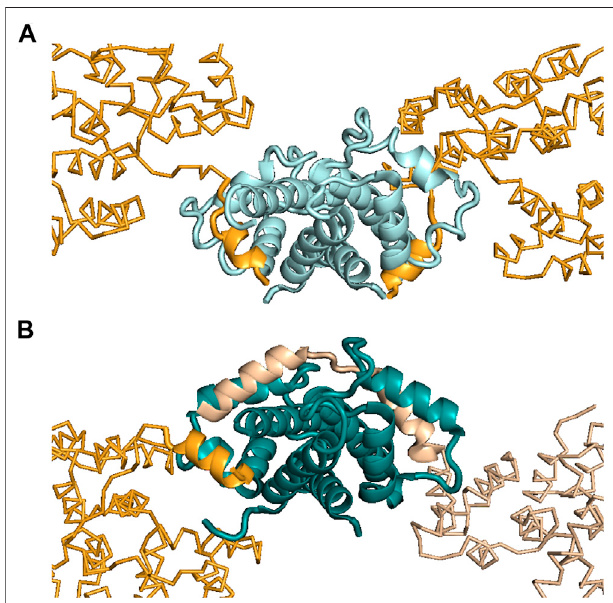
FIGURE 3 | Interactions made between ANXA2 and different S100 proteins. (A) Structure showing ANXA2 – S100A10 interactions (PDB: 4HRE) (Oh et al., 2013). (B) Structure showing ANXA2 – S100A4 interactions (PDB: 5LPU) (Ecsédi et al., 2017). S100A10 is presented in pale cyan, while S100A4 is shown in deep teal. The interacting N-terminus of ANXA2 is shown in bright orange (S100A10-type, symmetric binding) and in wheat (S100A4- type, asymmetric binding). Inspection of the crystal structures showed two ANXA2 molecules bound to S100A10 symmetrically (bright orange) and two bound to S100A4 asymmetrically (wheat and bright orange). However, in the case of S100A4, ITC studies showed the interaction to be formed with only one ANXA2 molecule in solution, i.e., not with two ANXA2 molecules. This arrangement would appear to require this one molecule to occupy both